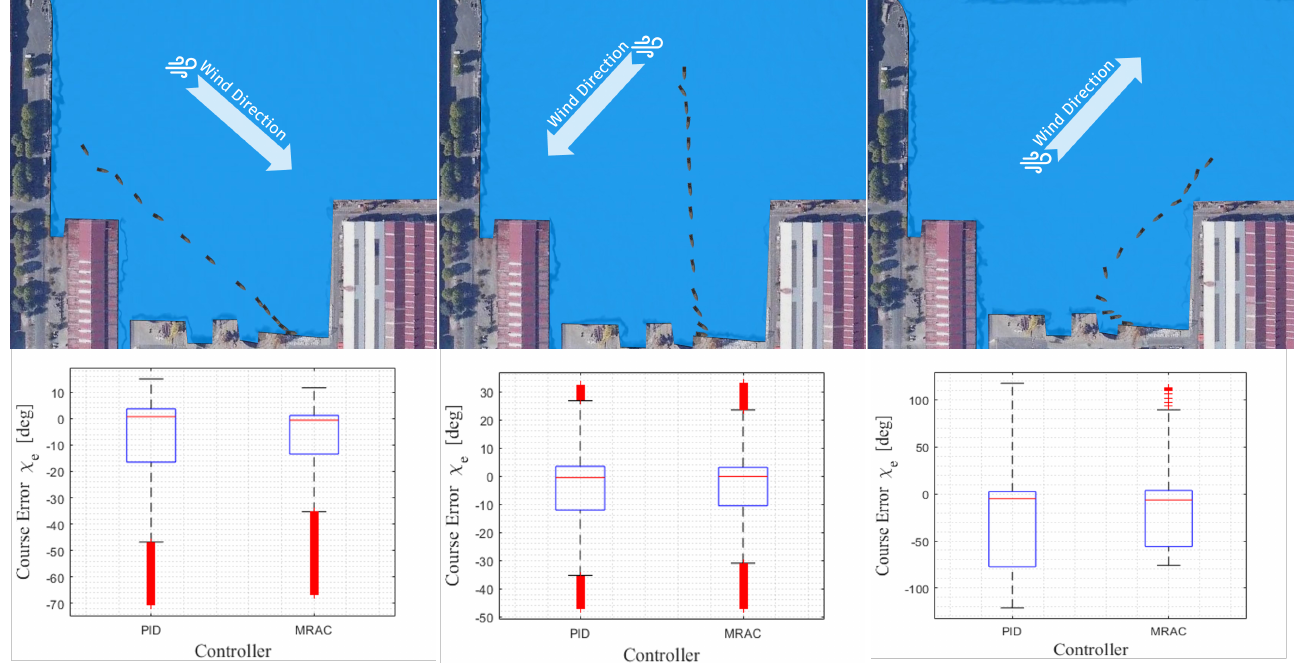
Figure 17. Trajectory and course error boxplot of parallel-type berthing simulation with different initial positions and wind